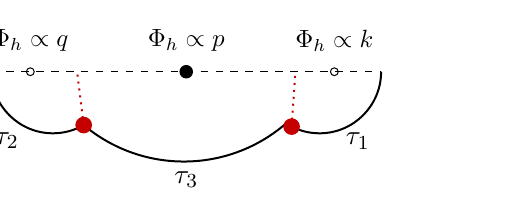
Figure 15 . Backreaction by two operator insertions (red dots) with three local horizons (black circles and black dot). Assuming that p < k; q , the middle horizon is the extremal RT surface that separates the left- and right entanglement wedges, indicated by the blue and green regions on the